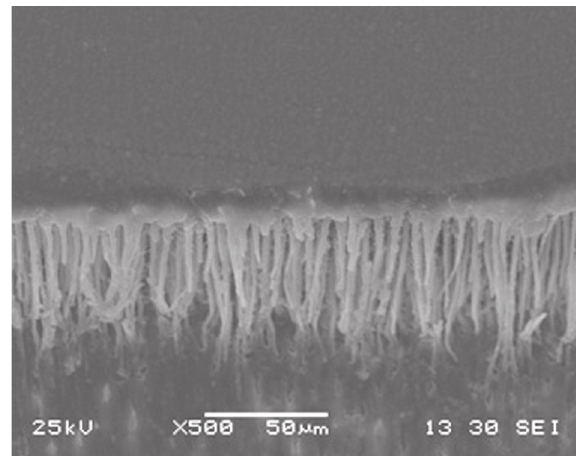
Figure 4- Photomicrograph of vestibular surface of Class I cavity preparation restored with P60/ Adper Single Bond 2 restorative